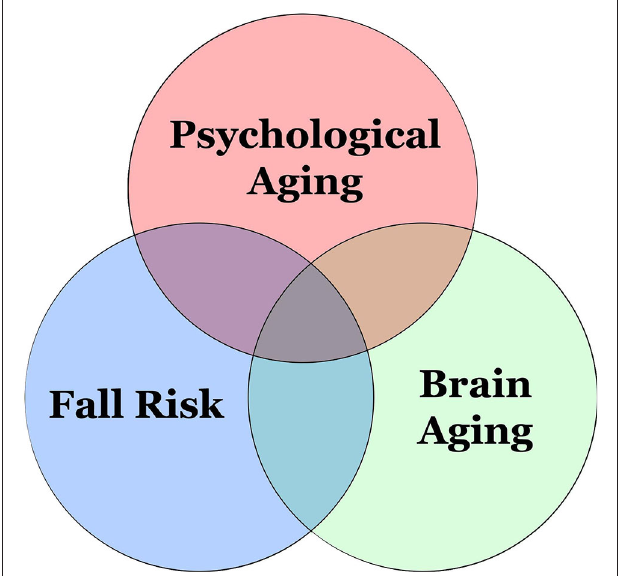
FIGURE 1 | Interrelations among fall risk and brain and psychological aging